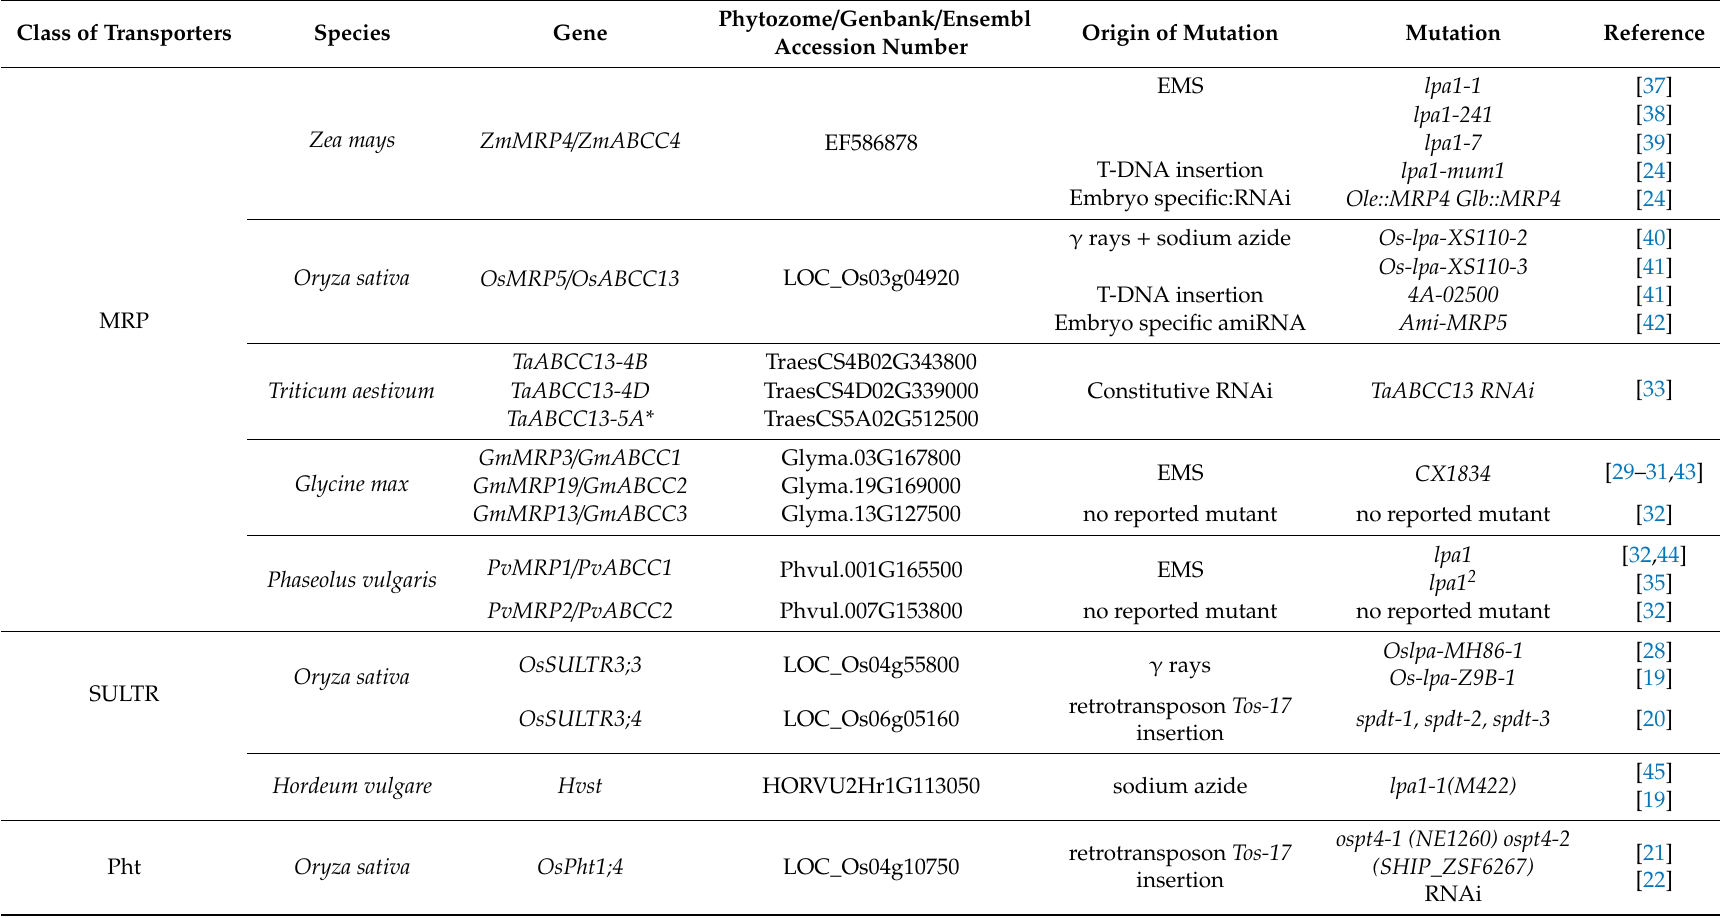
Table 1. Described cereal and legume transporters involved in PA accumulation and corresponding mutations a ff ecting PA seed / grain content. EMS stands for ethyl methanesulfonate. * Indicates incomplete